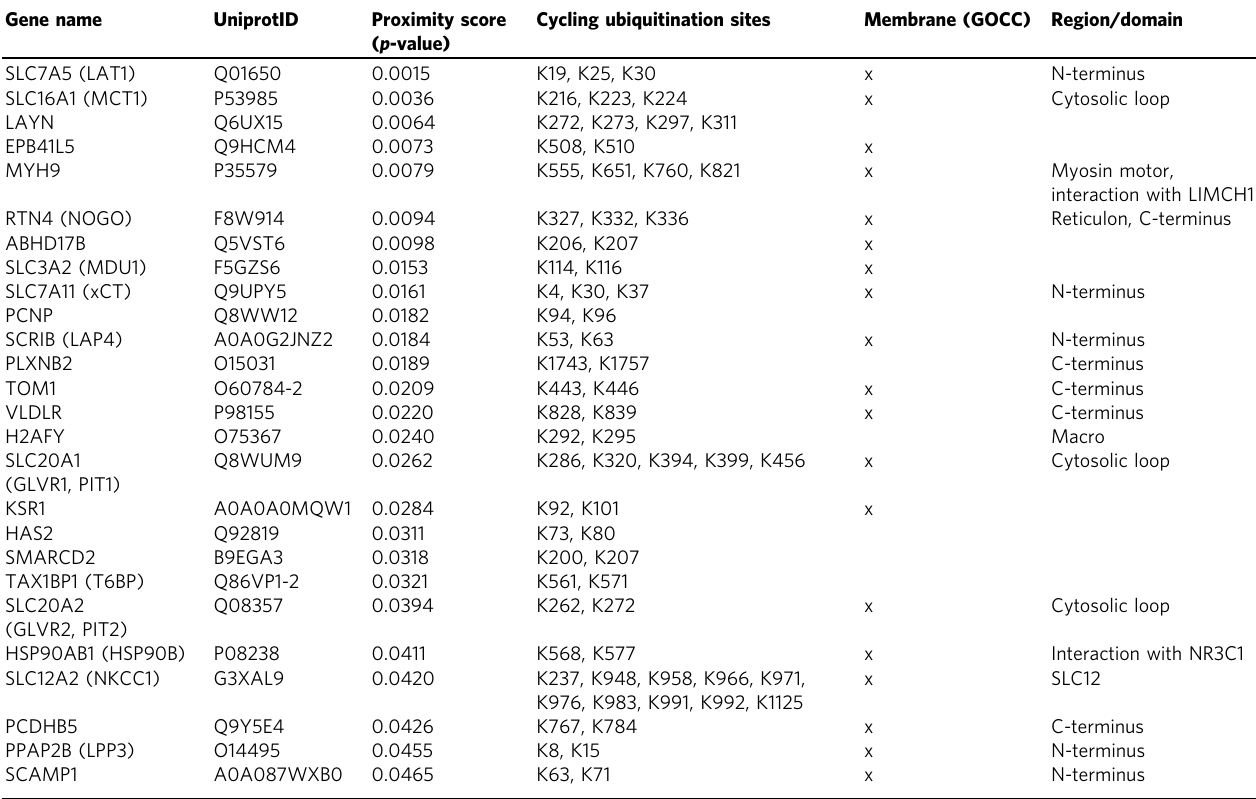
Table 1 Ubiquitination clusters with potential regulatory circadian